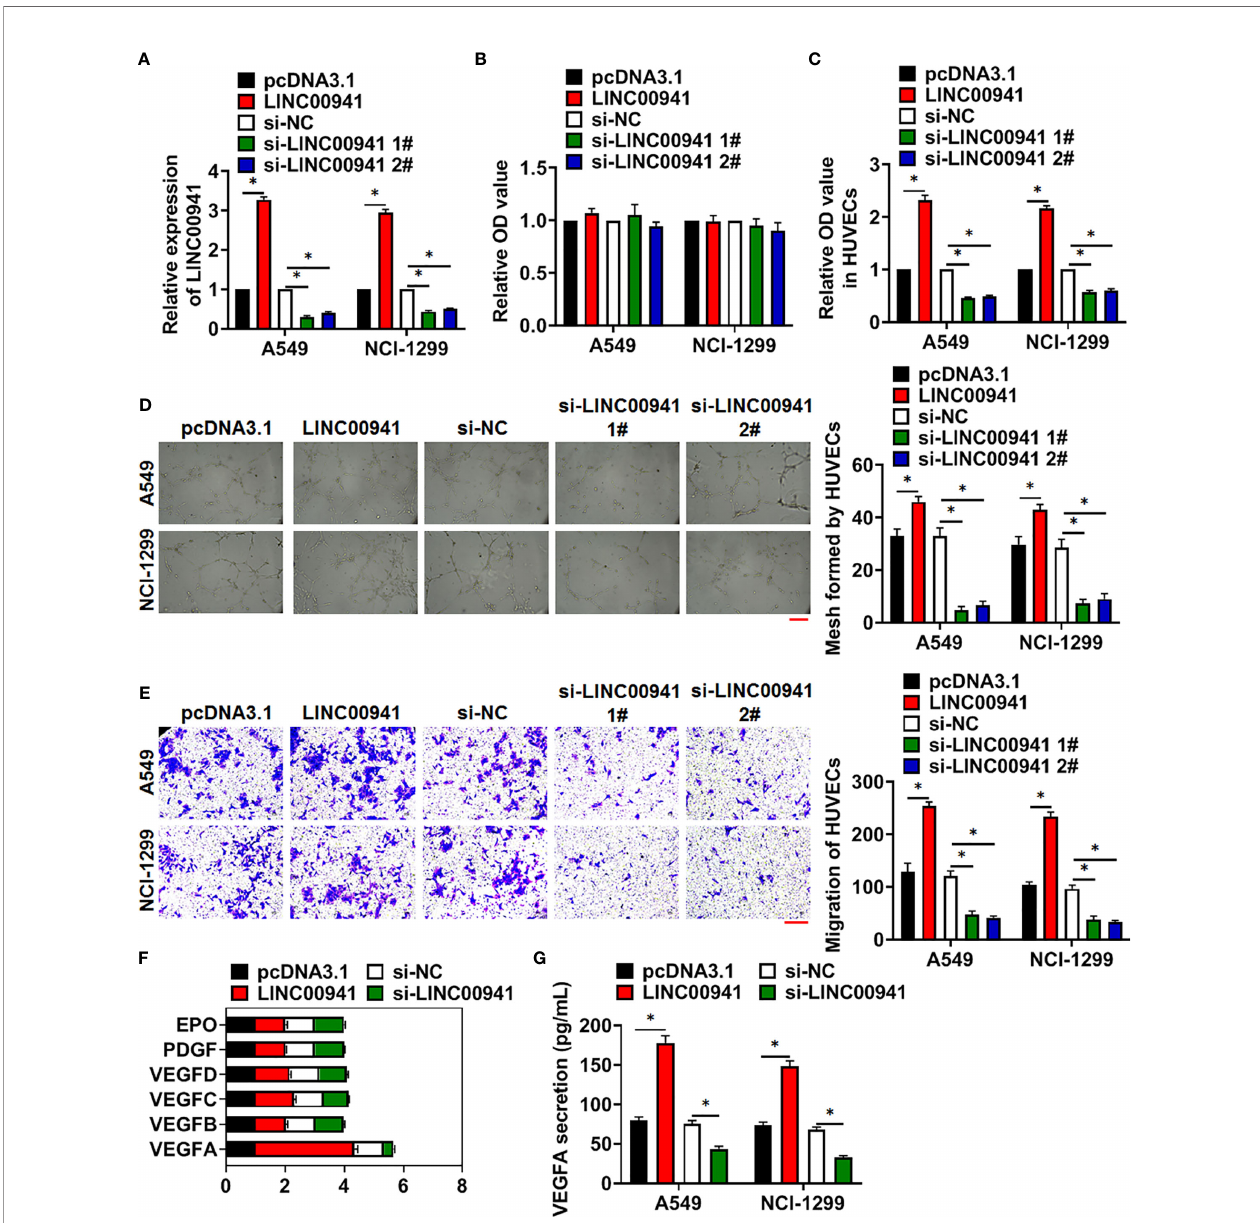
FIGURE 2 | LINC00941 in NSCLC cells promoted angiogenesis of HUVECs. Stable LINC00941 knockdown A549 and NCI-1299 cells, and exogenously overexpressed LINC00941 in A549 and NCI-1299 cells were constructed. (A) The expression of LINC00941 was determined by qRT-PCR. (B) MTT assay used to detect proliferation of A549 and NCI-1299 cells. HUVECs were cultured with supernatant of A549 and NCI-1299 cells stably expressed LINC00941 or si- LINC00941. (C) MTT assay used to detect proliferation of HUVECs. (D) Effect of LINC00941 expression in NSCLC cells on HUVECs in tube formation assay. Scale bar, 100 m m. (E) Transwell assay was to examine invasion of HUVECs. Scale bar, 100 m m. (F) The expression of the proliferation and migration-related genes in HUVECs. (G) The level of VEFGA in NSCLC cells in ELISA assay. Data are mean ± SD; *P < 0.05. All experiments were repeated three